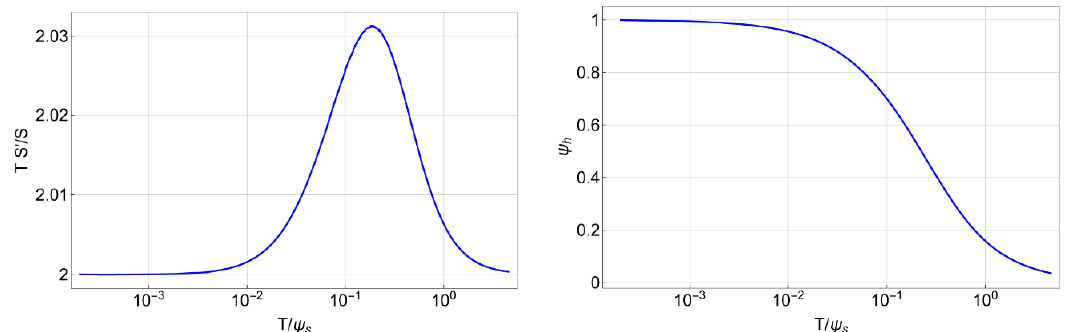
Figure 1 . The left panel shows the logarithmic derivative of the entropy of the system with respect to the temperature, while the right panel shows the horizon constant h as a function of the temperature. Here s = 1 = 2 and c = 1 ; q = (cid:0)